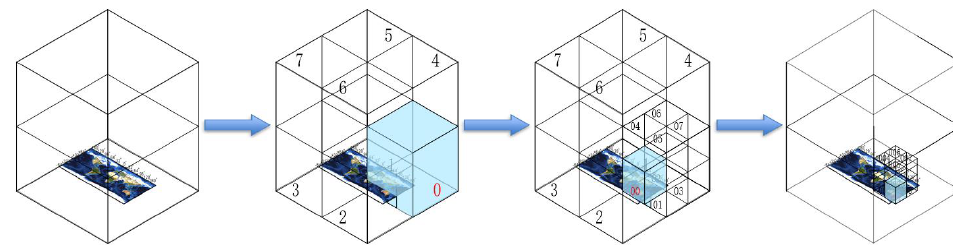
Figure 3. GeoSOT-3D meshing reference frame [35].